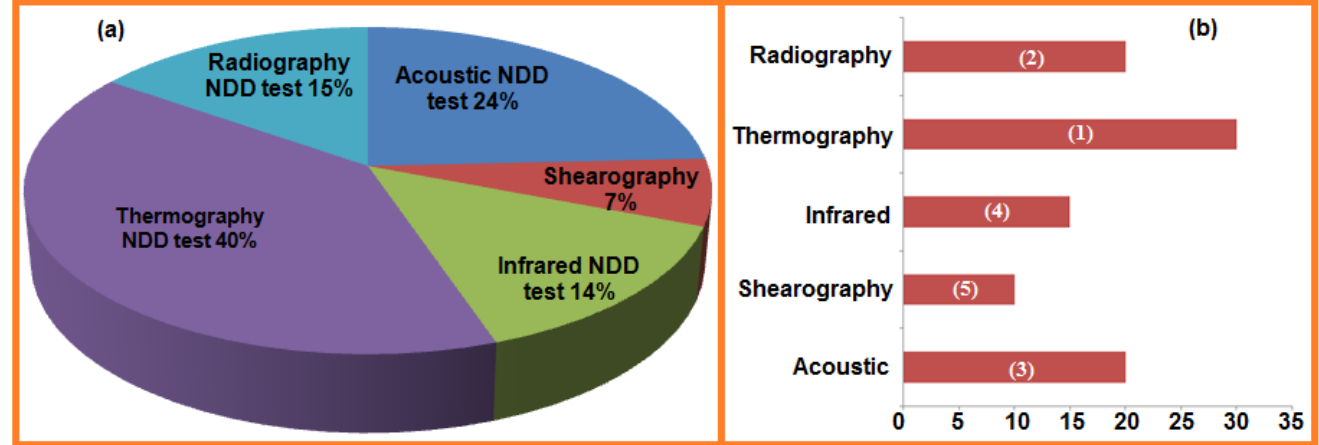
Figure 2. Recent development in the most practiced NDT techniques ( a ); number of papers reported and studied ( b ).